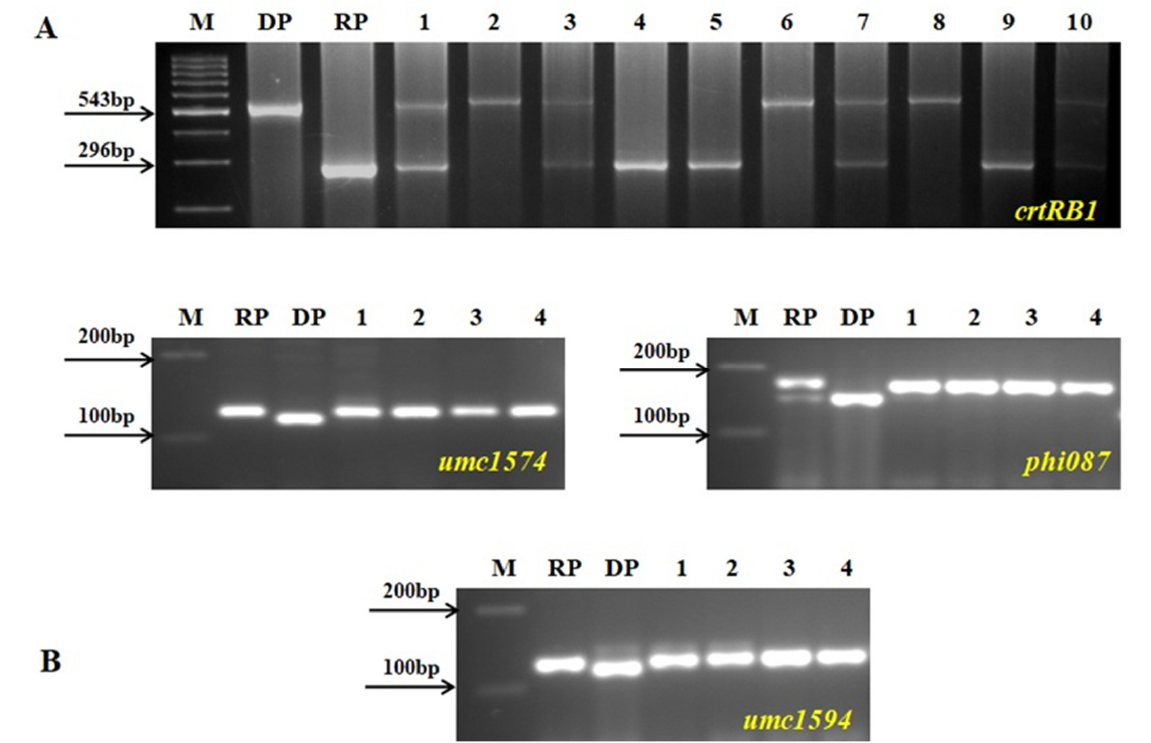
Figure 2. Genotyping in the backcross and selfed population of CAUM66 × UMI285β + . M, Ladder (100 bp); DP, donor parent; RP, recurrent parent. ( A ) Foreground screening; 1–10, segregating progenies. ( B ) Background screening: 1, CAUM66-54-9-12-2; 2, CAUM66-54-9-12-11; 3, CAUM66-54-9-12-13; 4, CAUM66-54-9-12-24.